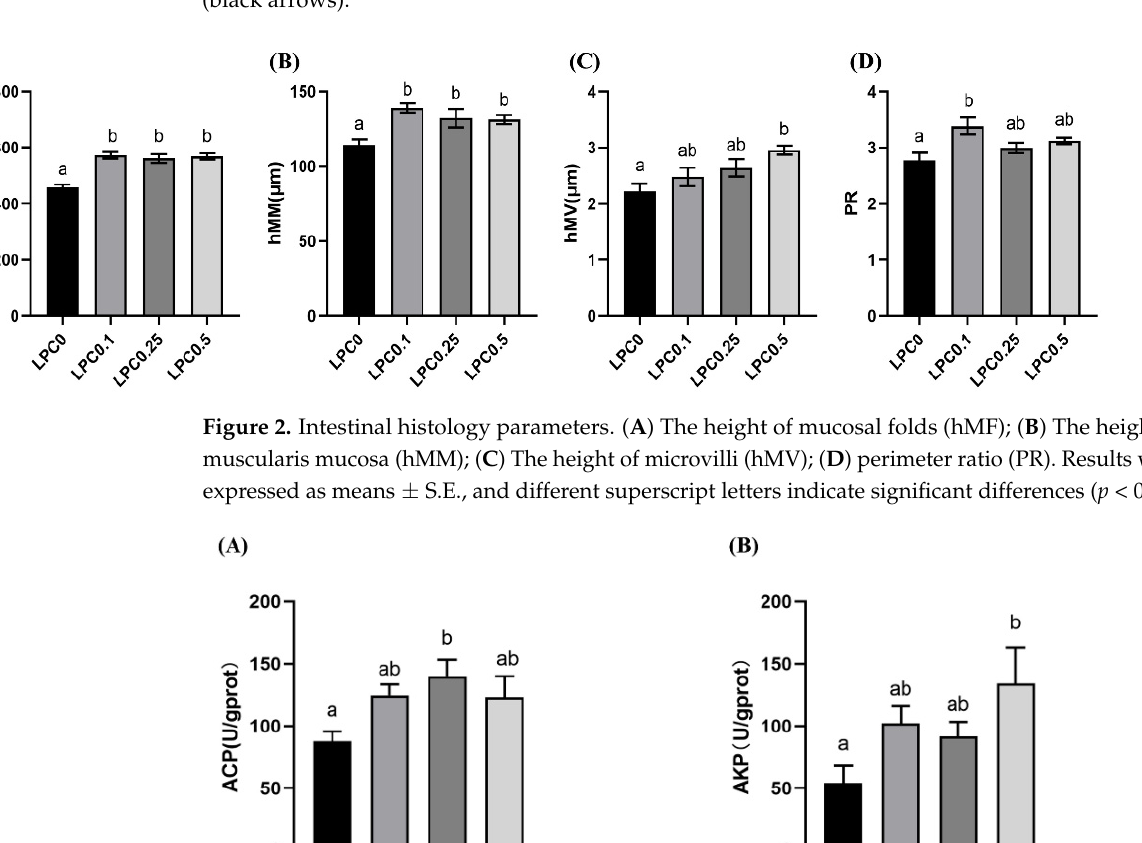
Figure 2. Intestinal histology parameters. ( A ) The height of mucosal folds (hMF); ( B ) The height of muscularis mucosa (hMM); ( C ) The height of microvilli (hMV); ( D ) perimeter ratio (PR). Results were expressed as means ± S.E., and different superscript letters indicate significant differences ( p < 0.05).